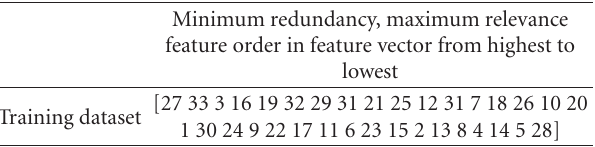
Table 2: Comparison of minimum redundancy and maximum relevance in the feature vectors between di ff erent training data sets is given in Figure 6. We used four di ff erent SVM kernels, but the relative relevance attributed to di ff erent features is comparable with all